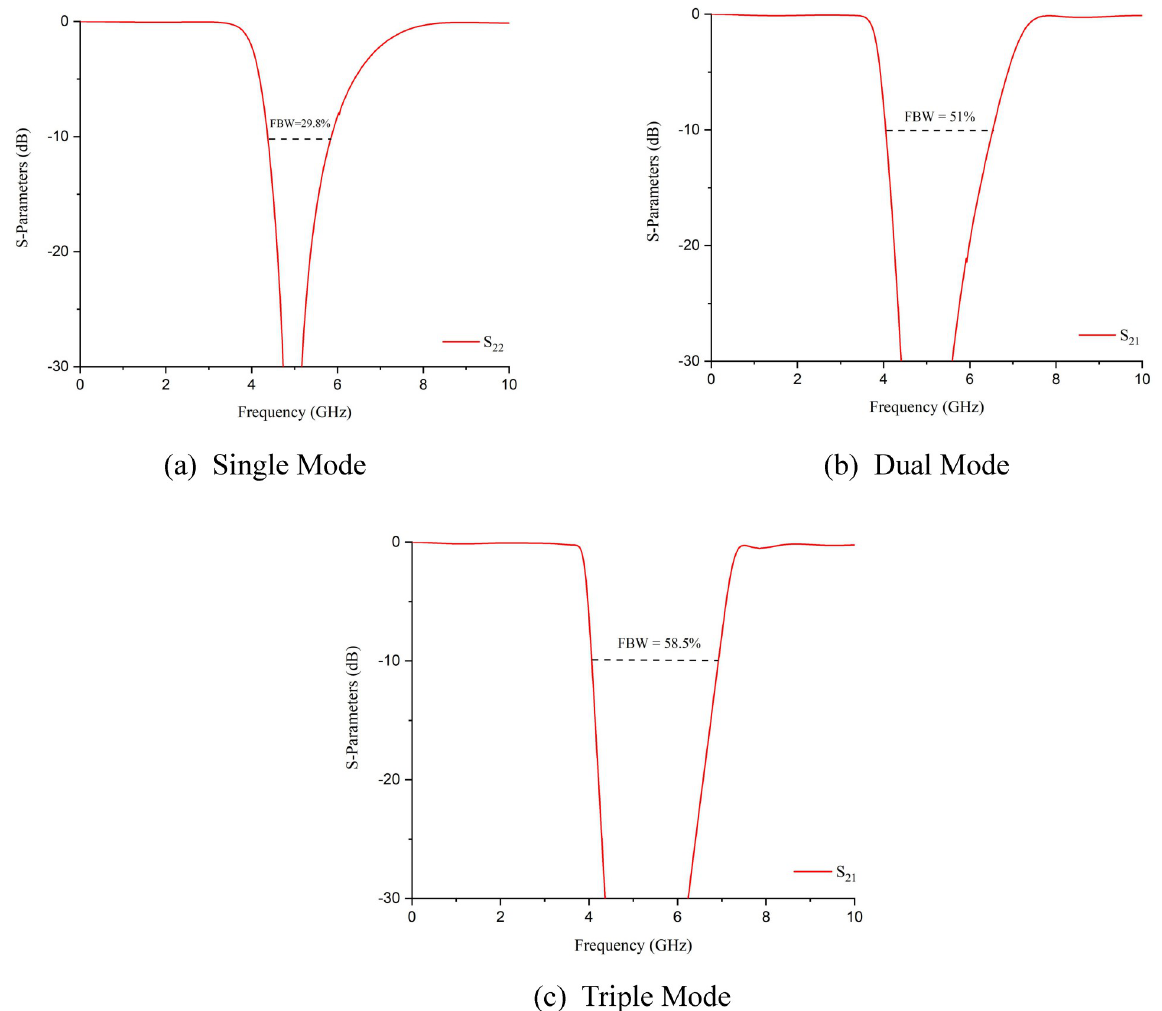
Fig 6. 10 dB Fractional bandwidth with different transmission